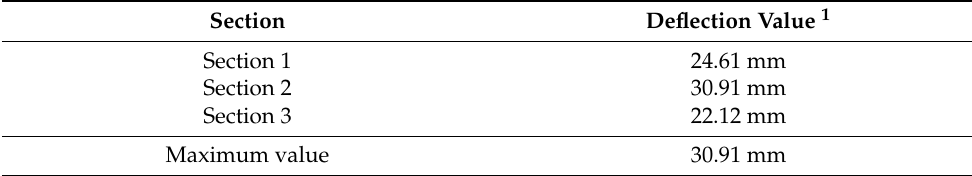
Table 2. Deflection value of each section (Campus building A).